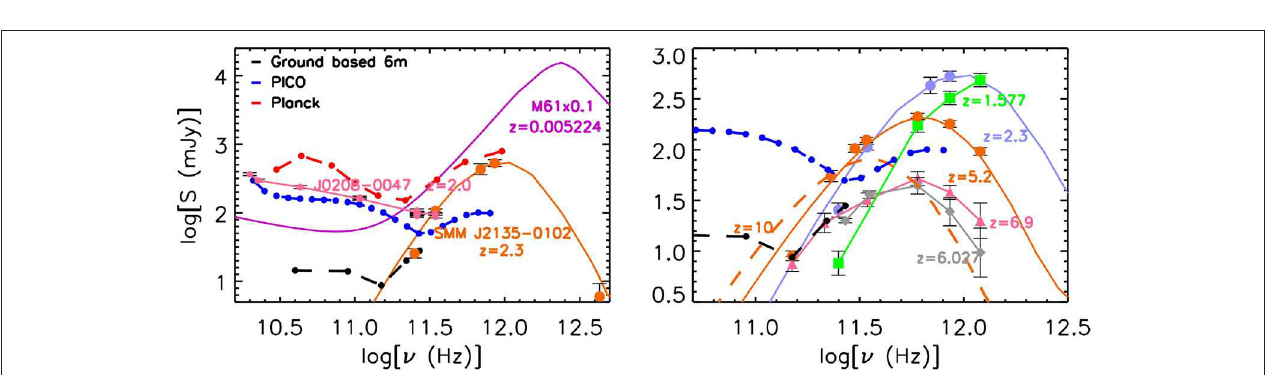
FIGURE 2 | Spectral energy distributions of extragalactic sources in the frequency range of CMB experiments, compared with the estimated detection limits of the PICO project and with the completeness limits of the SPT surveys extrapolated to 40 and to 270 GHz, to cover the range of the CMB-S4 project. The PCCS2 90% completeness limits in the “extragalactic zone” are also shown for comparison (in the left panel only). At wavelengths shorter than a few mm the dominant extragalactic population are dusty star-forming galaxies. At longer wavelengths radio sources, mostly blazars, take over. The spectral energy distributions (SEDs) of blazars are characterized by a relatively flat continuum spectrum exemplified by that of J0208-0047 at z ≃ 2.0 (flat solid orange line). Dusty star-forming galaxies are a mixture of local and high- z strongly gravitationally lensed objects. Local galaxies are, by far, the brightest extragalactic sources at sub-mm wavelengths. Their SEDs are exemplified by that of the dusty star-forming galaxy M61, scaled down by a factor of 10. Some examples of SEDs of strongly lensed galaxies are shown: SDP9 ( z = 1.577; Negrello et al., 2010), SMMJ2135-0102 ( z = 2.3259; Swinbank et al., 2010), HLSJ091828.6+514223 ( z = 5.2; Combes et al., 2012), HATLASJ090045.4+004125 ( z = 6.027; Zavala et al., 2018), and SPT-SJ031132-5823.4 ( z = 6.9; Strandet et al., 2017). The dashed orange SED represents that of HLSJ091828.6+514223 scaled to z = 10 to show that galaxies like it are visible up to very high redshifts both by ground-based and by space-borne next generation CMB